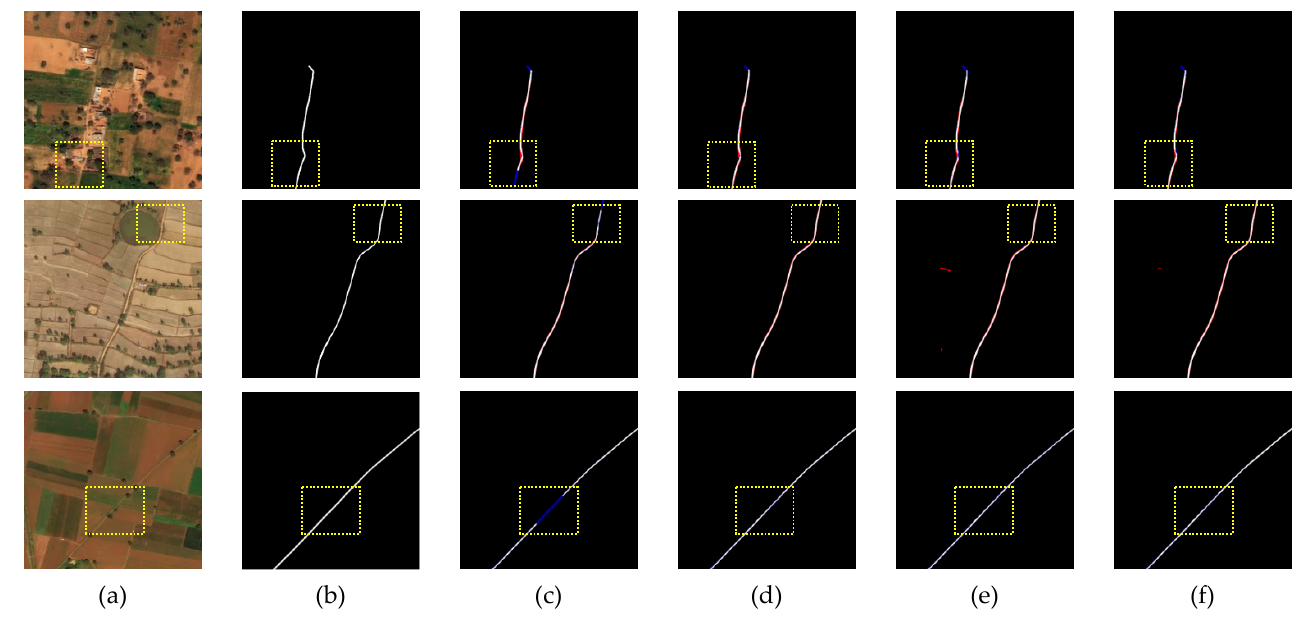
Figure 8. Comparison of visualization results before and after adding MFEM. (a) Image; (b) Label; (c) Baseline results; (d) Baseline + MFEM results; (e) Baseline+MFEM+CAM results; (f) Baseline+MFEM+CAM+SPM results. White: true positive. Black: true negative. Blue: false negative. Red: false positive.